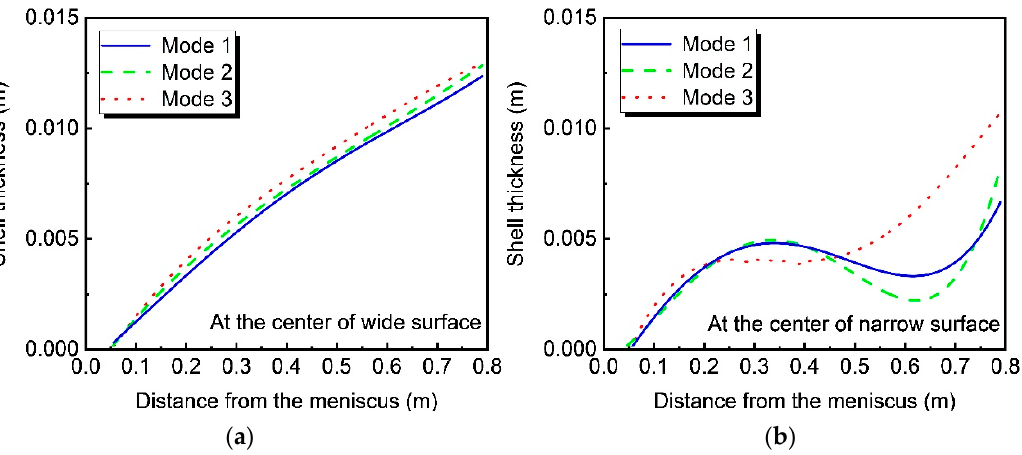
Figure 14. Variation of solidified shell thickness under different EMBr modes. ( a ) Shell thickness at the center of wide surface; ( b ) shell thickness at the center of narrow surface.